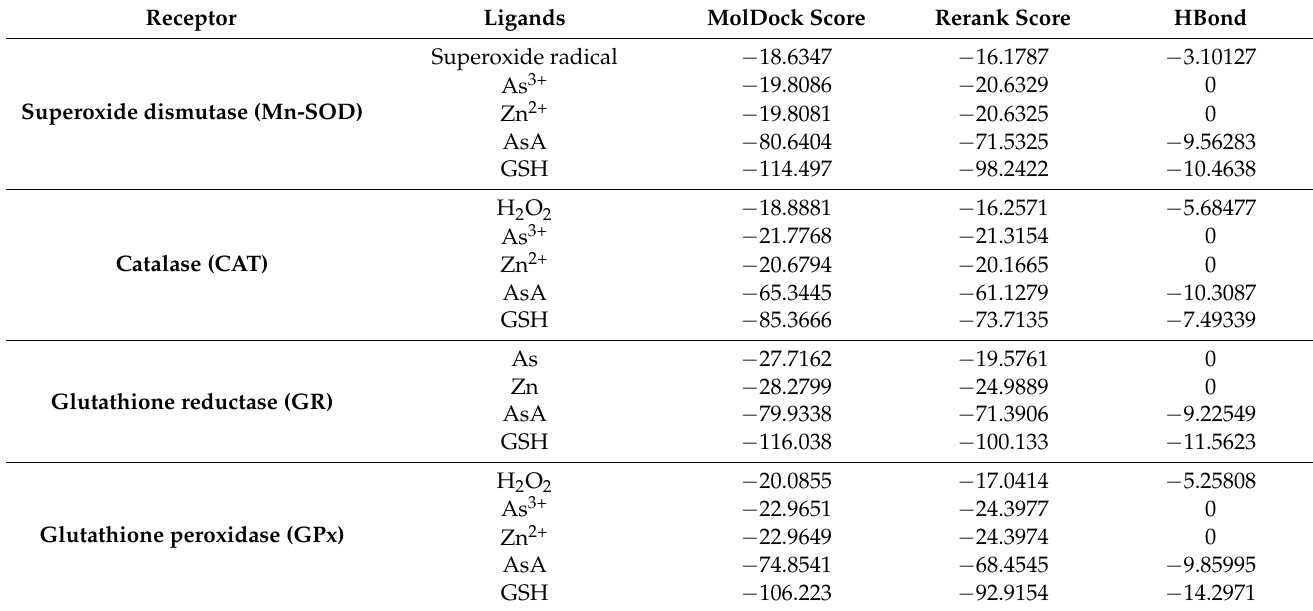
Table 4. Docking scores of the ligands at the active sites of the receptors. The scores were obtained following docking using MVD, and are the predicted free energy of the binding of the ligands with the receptor, in